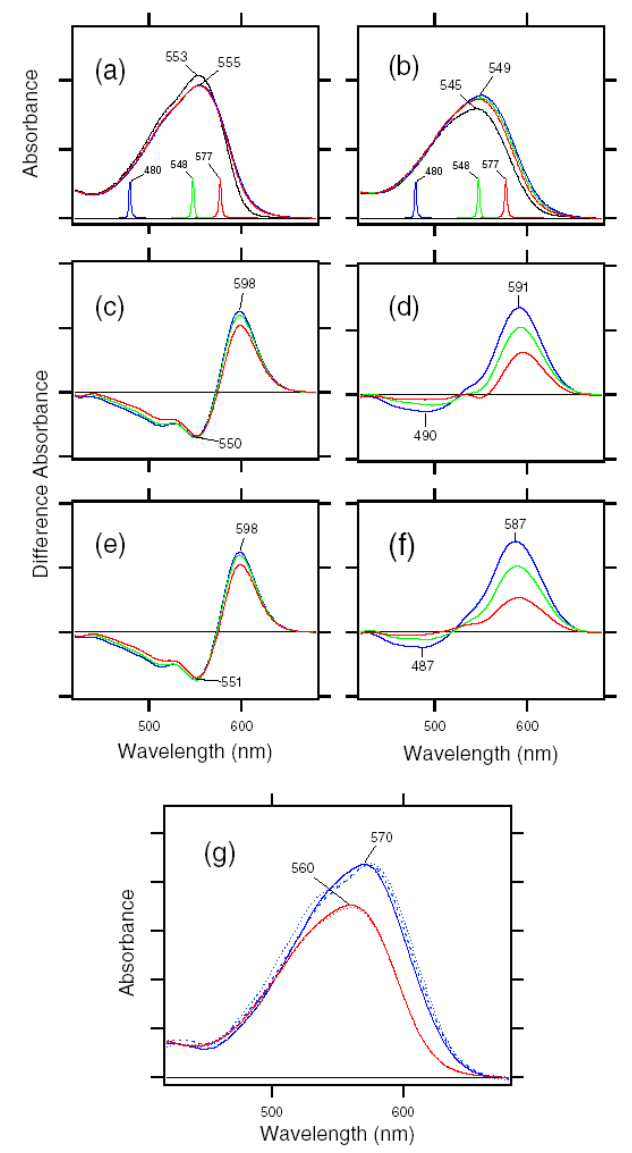
Figure 25. Determination of the absorption spectra of the K intermediates of ASR and AT ASR at 130 K. Black solid line represents the absorption spectra of the dark-adapted (a) 13C and light-adapted (b) ASR at 130 K. Blue, green, and red spectra are those by illumination with a 480, 548, and 577 nm light through interference filters (sharp colored peaks in the figure), respectively. (c) and (d). Light-minus-dark difference absorption spectra of the dark-adapted (c) and light-adapted (d) ASR by illumination with 480 (blue), 548 (green), and 577 (red) nm lights at 130 K. (e) and (f). K-minus-ASR (e) and K-minus-ASR (f) AT 13C difference absorption spectra by illumination with 480 (blue), 548 (green), and 577 (red) nm lights at 130 K. Blue solid, dotted, and broken lines represent the spectra of the K intermediate of ASR obtained from the blue and red, green and red, and blue and green 13C spectra in f. We regarded the red and blue solid lines as the spectra of the K intermediates of ASR and ASR , respectively. One division of the y-axis corresponds to 0.2 (a,b), AT 13C 0.04 (c,d,e,f) and 0.1 (g) absorbance units. These figures are reprinted with permission from Kawanabe et al . [71]. Copyright 2007 American Chemical